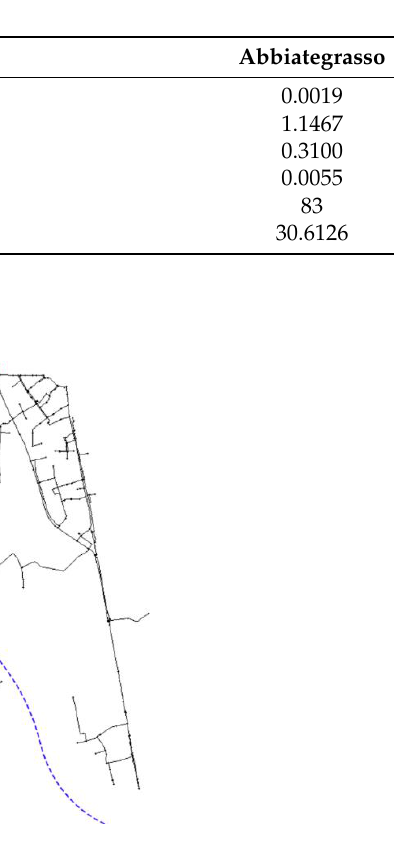
Table 3. Probabilistic distances vs. loss of efficiency.